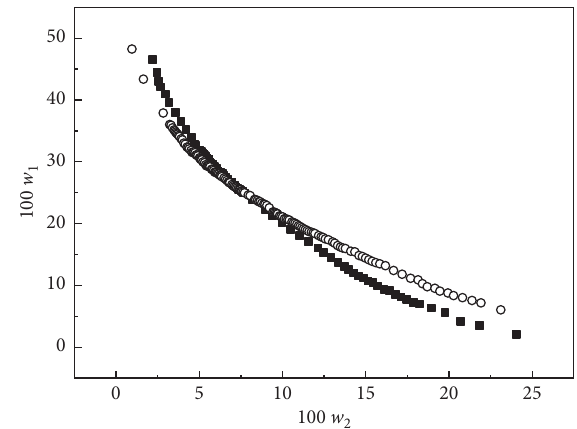
Figure 2: Effect of the mass composition of the alcohol on binodal curves for the systems consisting of polyethylene glycol+ ethanol+Na 2 SO 4 +water at T � 308.15K and the systems consisting of isopropyl alcohol +ethanol +Na 2 SO 4 +water at T � 308.15K; ■ the systems consisting of polyethylene glycol; ○ the systems consisting of isopropyl